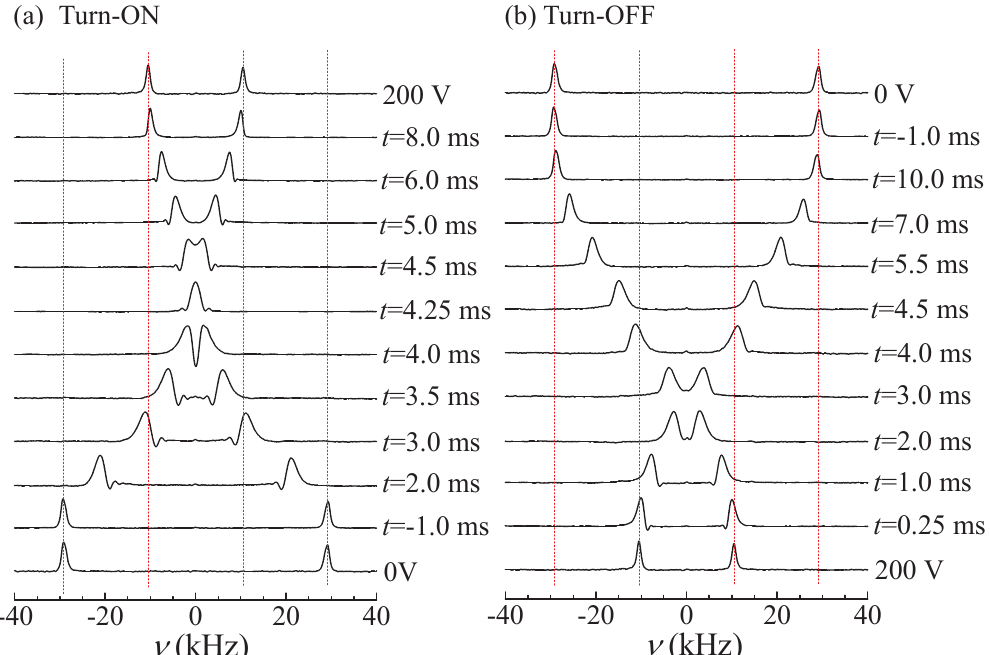
Figure 2. Two sets of time-resolved deuterium NMR spectra for the turned-on ( a ) and turned-off ( b ) experiments recorded for 5CB-d 2 at 15 ◦ C and α = 79.7 ◦